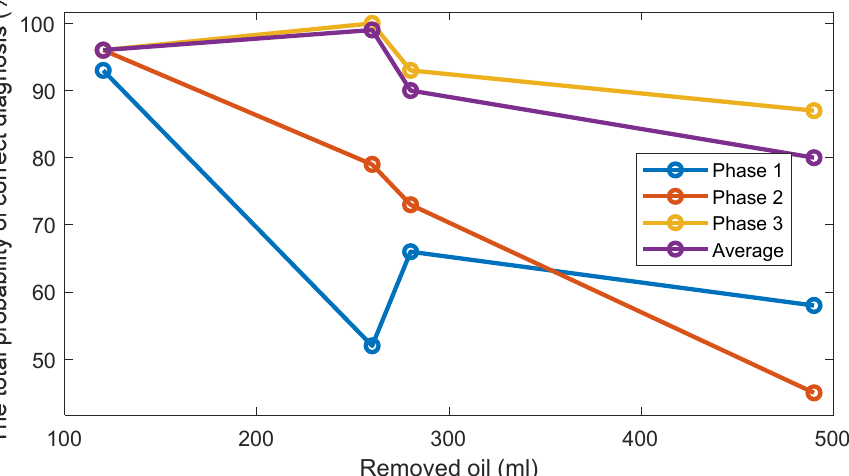
Figure A2. The TPOCD, provided by technology 1 (the first harmonic of the supply frequency) for 3 phases and 4 levels of oil removal compared to the standard oil level (Day 2).